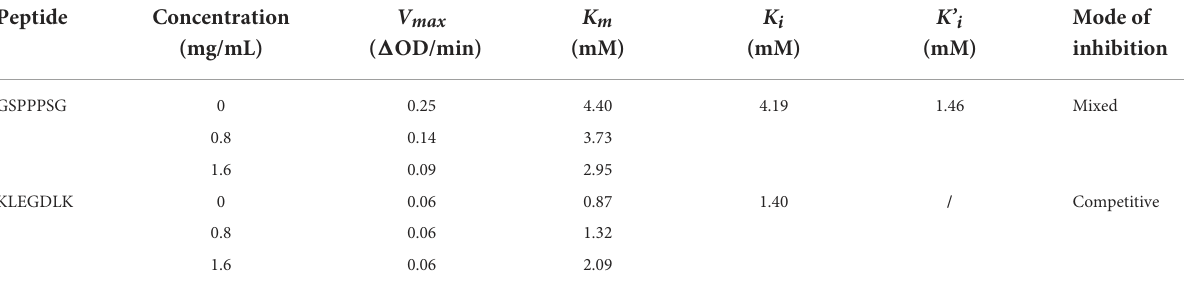
TABLE 1 V max , K m , K i , and K’ i of the interaction between PL and GSPPPSG&KLEGDLK. Peptide